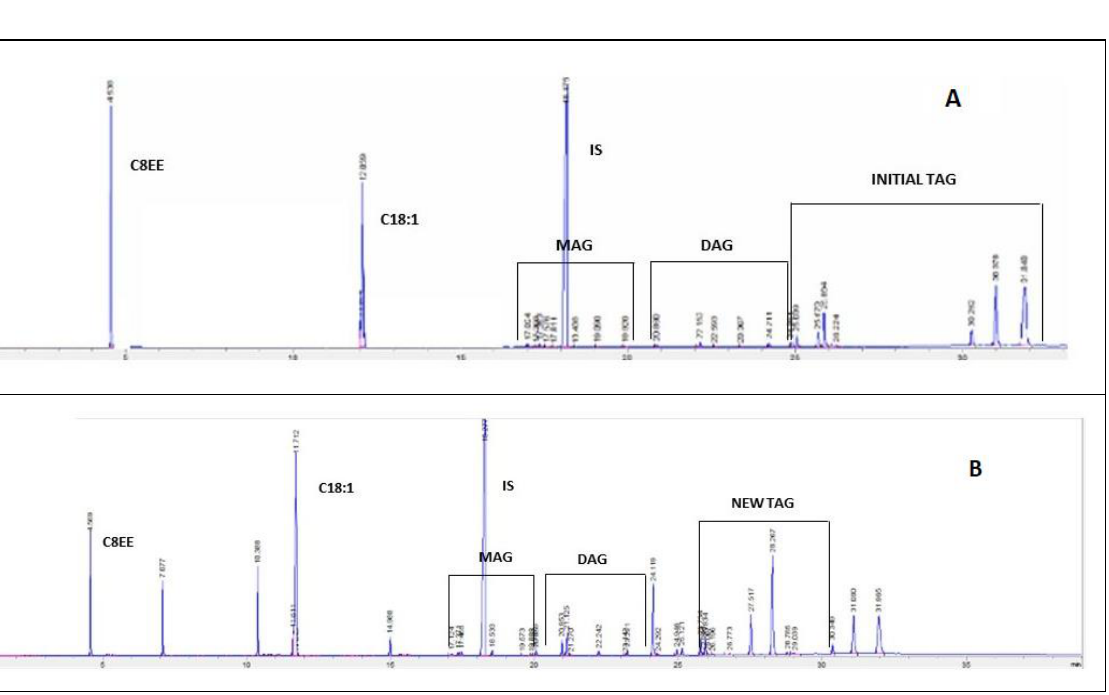
Figure 4. Example of chromatograms obtained ( A ) for the initial reaction medium (OPO and C8EE) and ( B ) at a steady state of continuous interesterification catalyzed by Lipozyme TL IM (C 18:1 — peak of oleic acid; IS — peak of the internal standard; MAG — peaks of monoacylglycerols; DAG — peaks of diacylglycerols; Initial and New TAG- peaks of initial TAGs and new TAGs formed during the reaction).